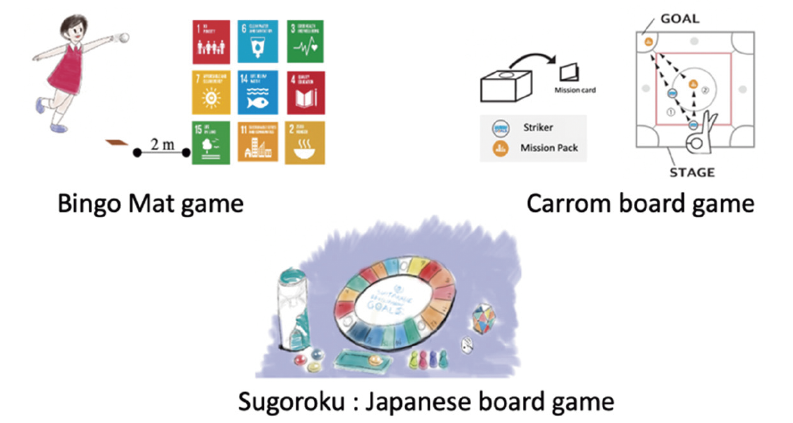
Figure 1. Three games selected from the ideathon by the application of DBL (Ichitsubo, Yamaguchi et al.,